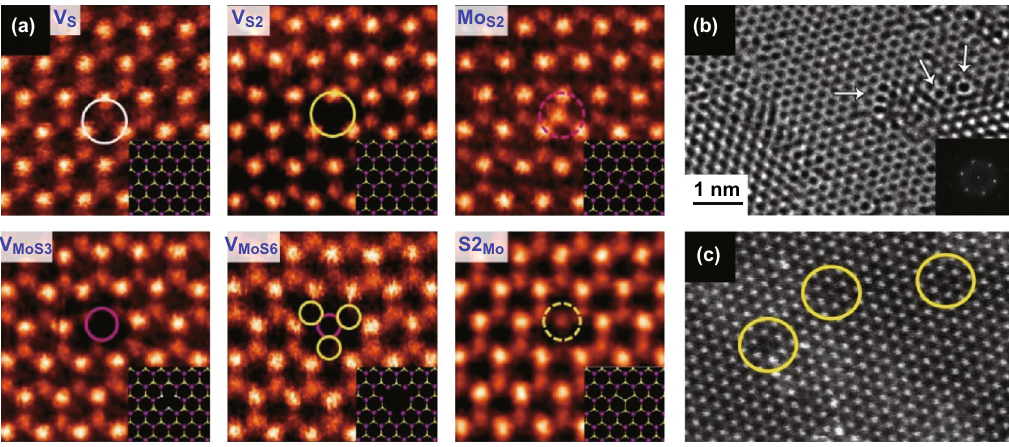
Fig. 16 Intrinsic 0D defects of 2D TMDCs during the CVD growth. a Annular dark-field (ADF) images of CVD grown of MoS 2 monolayer. Point defects and fully relaxed structural model (inset) of mono-sulphur vacancy (V S ), disulphur vacancy (V S2 ), antisite defects where a Mo atom substituting an S 2 column (Mo S2 ), vacancy complex of Mo and nearby three sulphur (V MoS3 ), vacancy complex of Mo nearby three disulphur pairs (V MoS6 ), and a S 2 column substituting a Mo atom (S2 Mo ). Purple, yellow and white circles indicate Mo, top layer S and bottom layer S, respectively. Adapted with permission from Ref. [141]. Copyright 2013, ACS Publications. b HRTEM images of point defects in 2D WS 2 struc- ture generated during growth of the oxide and consequent conversion to sulphide. Inset shows the corresponding fast Fourier transform (FFT) of the TEM micrograph. Adapted with permission from Ref. [143]. Copyright 2013, ACS Publications. c HRTEM micrograph of a 2D WS 2 grown by thermal reduction/sulphurisation method with yellow circles highlighting the intrinsic point defects. Adapted with permission from Ref. [142]. Copyright 2015, ACS